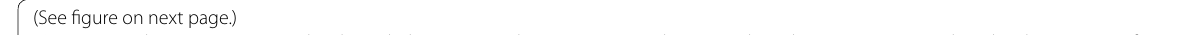
Fig. 9 Nanoplasmonics integrated with guided-wave nanophotonics. a Nanoplasmonics-based CO 2 sensor (Reproduced with permission from [174]). b Nanoplasmonic hotspots excited by light propagating in a dielectric waveguide (Reproduced with permission from [185]). c Near-field nanoplasmonics measurement by the aperture-less scanning optical microscopy (Reproduced with permission from [187]). d Nanofocusing on waveguide using a nanoplasmonic tip with 20 nm curvature (Reproduced with permission from [188]). e Surface-enhanced Raman Spectroscopy using bow-tie nanoantenna array on waveguide (Reproduced with permission from [189]). f Surface-enhanced Raman Spectroscopy